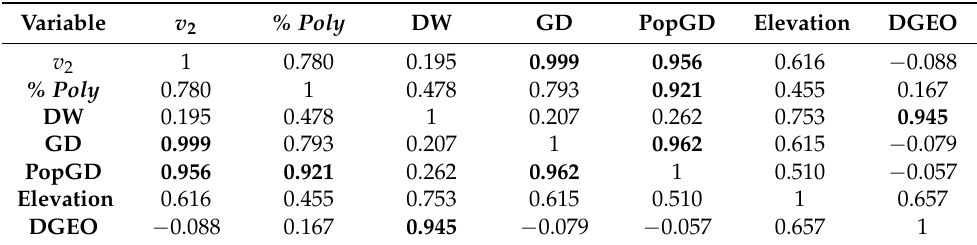
Table 7. Correlations between genetic and geographic variants of Pinus leiophylla and the different peripheral and central populations of this species.